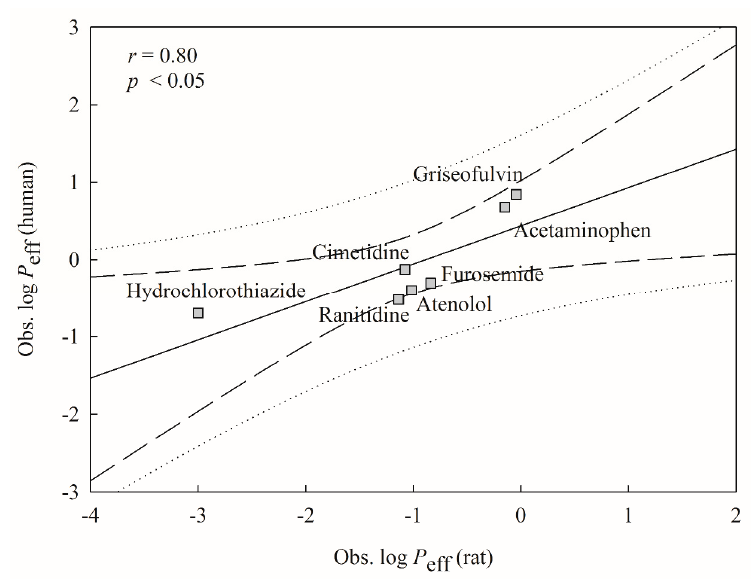
Figure 6. Observed human log P eff versus observed rat log P eff for the molecules in the mock test. The solid line, dashed lines, and dotted lines correspond to the mock test regression of the observed data, 95% confidence interval for the mock test regression, and 95% confidence interval for the observation, respectively.